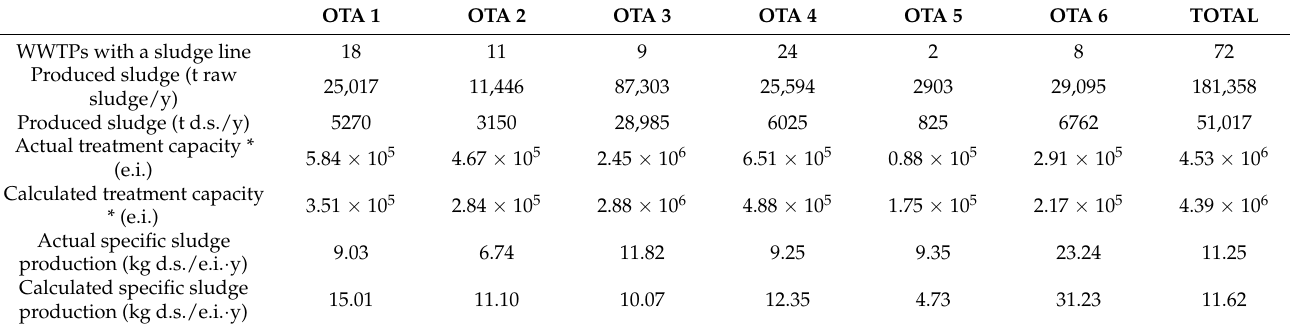
Table 2. Production of sludge in the WWTPs located in the territory of the Piemonte region and indexes of specific sludge